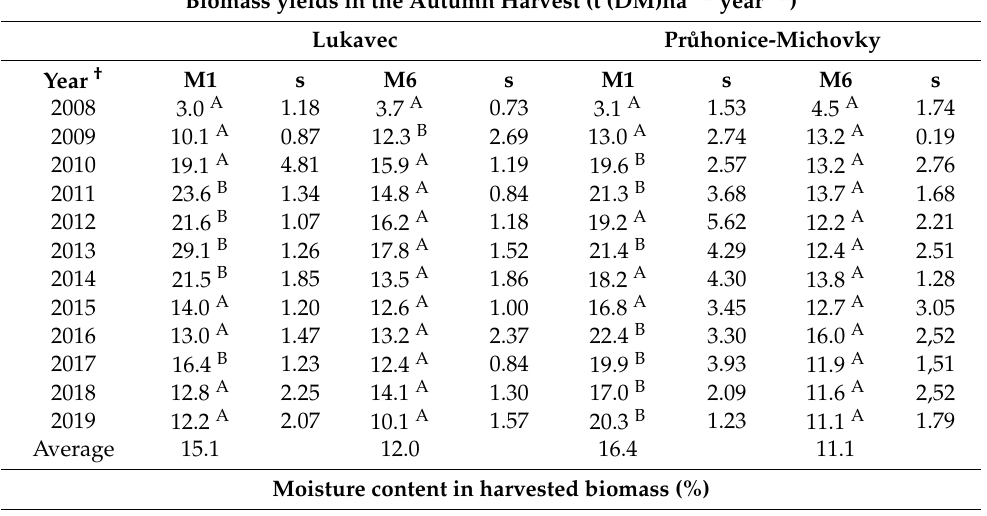
Table 6. Dry biomass yields in the autumn harvest and moisture content in biomass from autumn and spring harvests of Miscanthus clones M1 and M6 in the clonal experiment (Lukavec, Pr˚uhonice-Michovky). Biomass yields in the Autumn Harvest (t (DM)ha − 1 year − 1 ) Lukavec